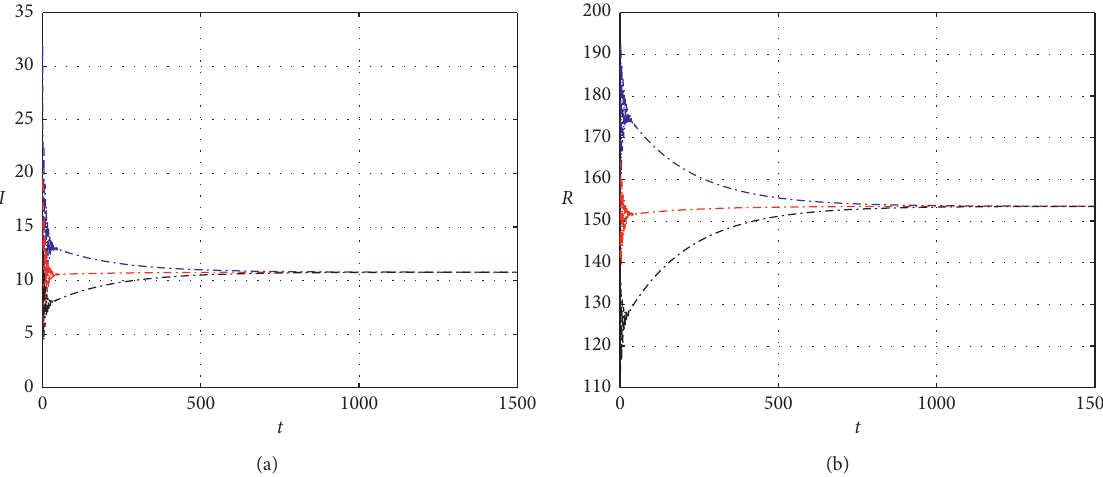
( τ ) < 3 q ( τ ) and R ( τ ) > 1: (a) the infectious computer; 1 0 2